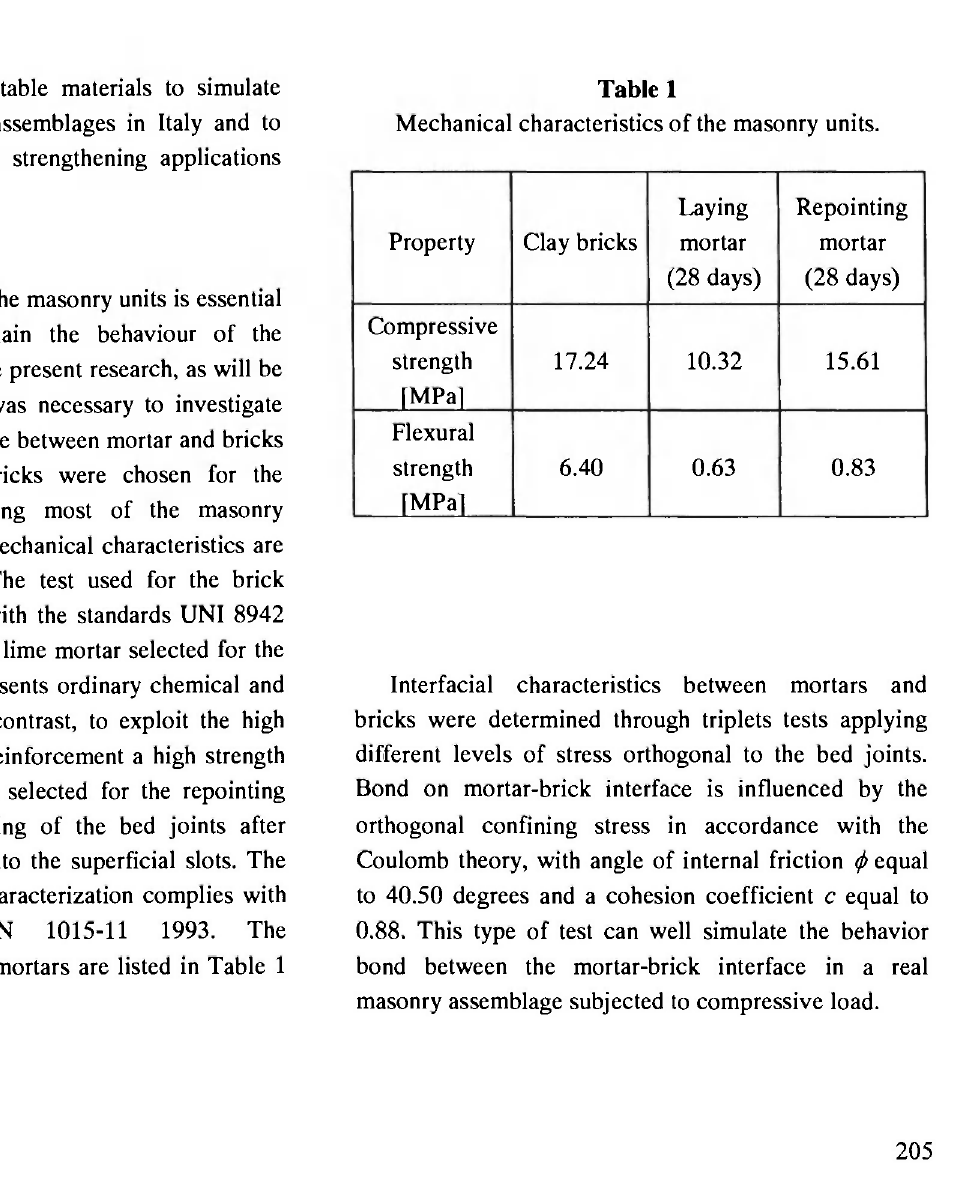
Fig. 1: Placement of the strip and repointing with mortar.